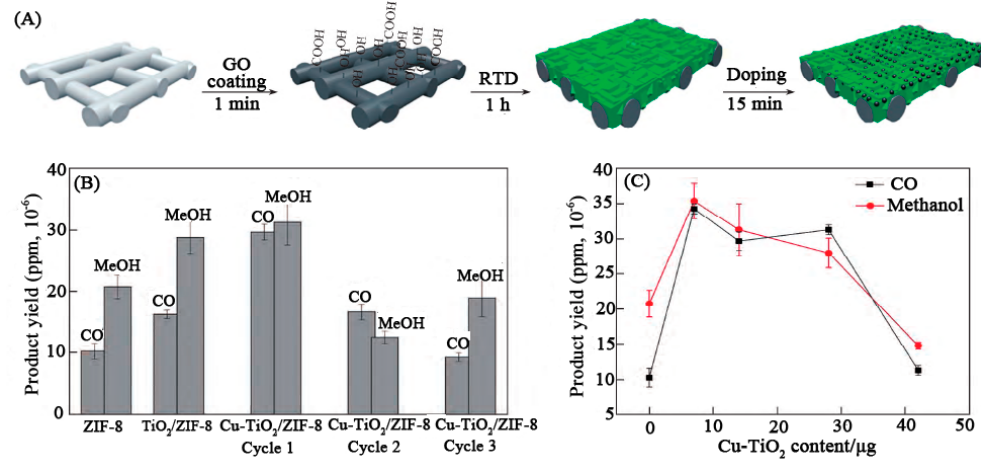
Figure 5. Fabrication of Cu-TiO 2 / ZIF-8 membranes ( A ), e ff ect of membrane composition ( B ) and Cu-TiO 2 nanoparticles loading on the product yields ( C ). Reprinted from ref. 93 with permission by the American Chemical Society.